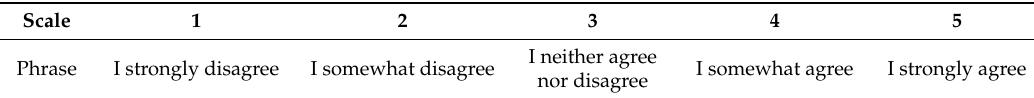
Table 1. The scale used to evaluate the company in terms of sub-criteria.